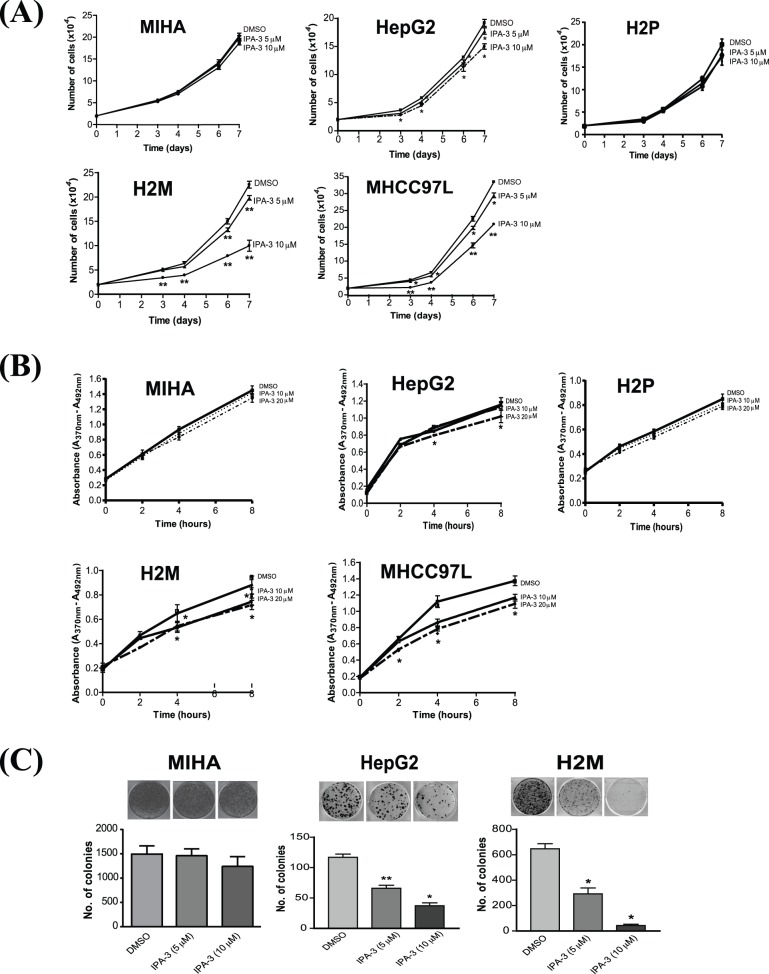
IPA-3 suppressed cell proliferation.(A) The effect of IPA-3 on the cell proliferation rates of MIHA (upper, left panel), HepG2 (upper, middle panel) H2P (upper, right panel), H2M (lower, left panel) and MHCC97L (lower, right panel) cells. Statistical analysis was performed by comparing with the value of DMSO control. *P<0.05, **P<0.01 (ANOVA). (B) BrdU labeling assays of MIHA (upper, left panel), HepG2 (upper, middle panel), H2P (upper, right panel), H2M (lower, left panel) and MHCC97L (lower, right panel) cells. *P<0.05 (ANOVA) compared with the DMSO control. Error bars, mean ± SD of triplicate samples. (C) Representative plates of colony formation assay of MIHA (left panel), HepG2 (middle panel) and H2M cells (right panel). Bar chart of colony formation assay (lower panel). *P<0.001, **P<0.01 (ANOVA) compared with the DMSO control. Error bars, mean ± SD of triplicate samples.